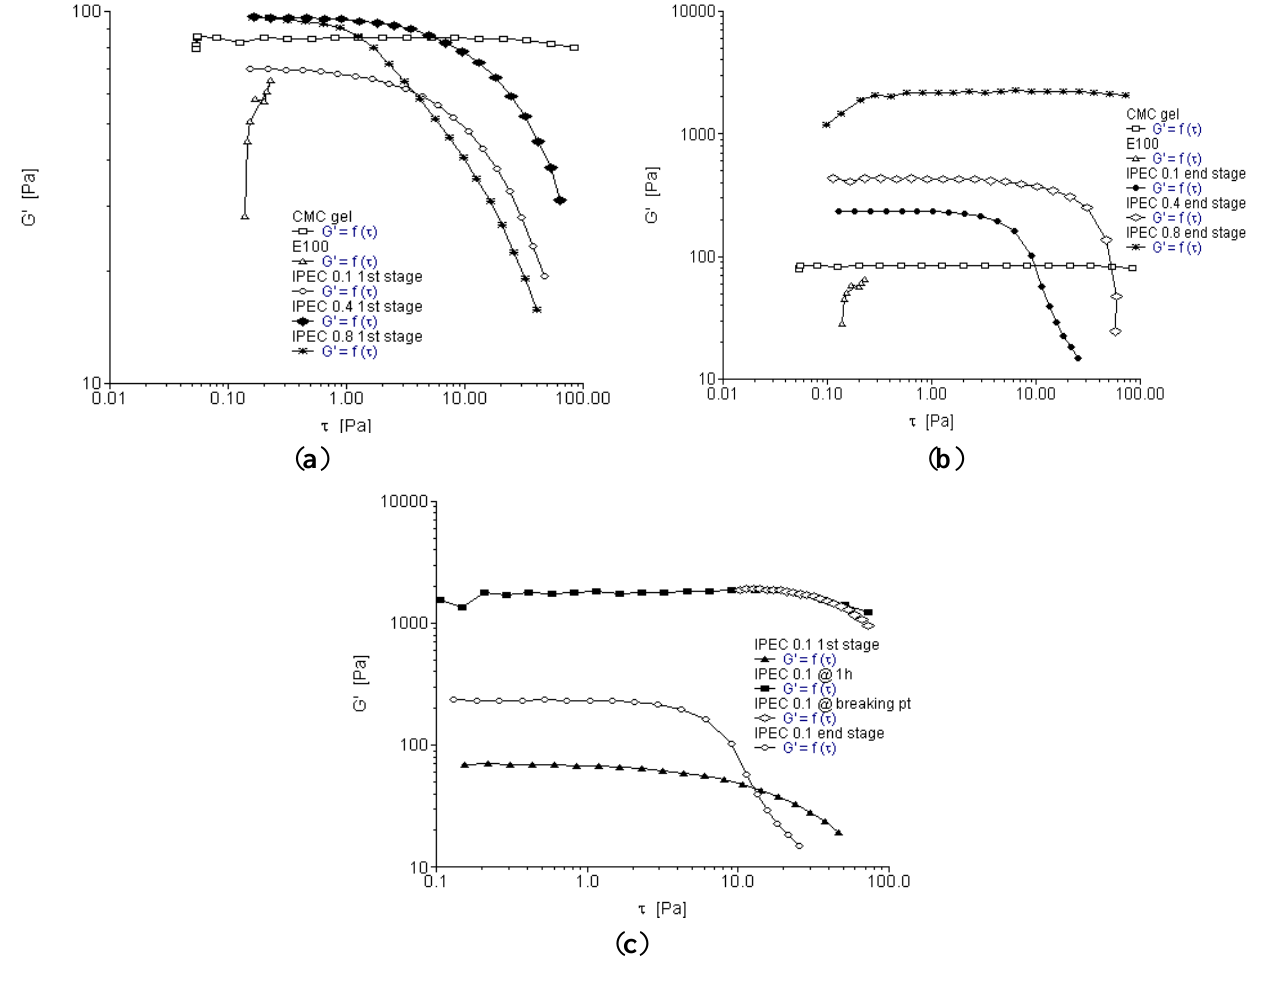
Figure 5. Elastic modulus as a function of shear stress for ( a ) the native polymers and IPEC at the first stage of synthesis at frequency of 10 Hz; ( b ) the native polymers and IPEC at end stage of synthesis at frequency of 10 Hz; and ( c ) IPEC 0.1 N at the 4 sampling points of synthesis at frequency of 10